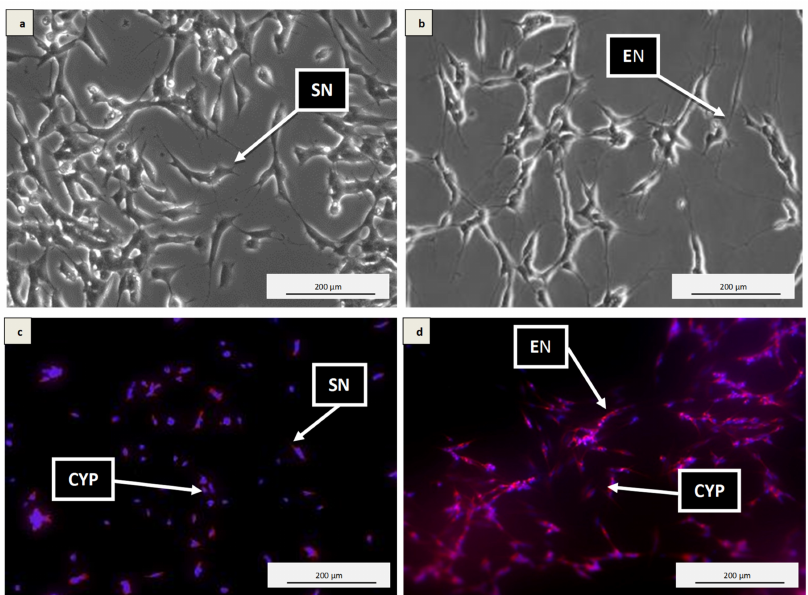
Figure 1. Micrographs of SH-SY5Y cell differentiation by 10 µ M RA. ( a ) Undifferentiated SH-SY5Y cells cultured in 10% heat-inactivated FBS complete growth media for 7 days and viewed under phase contrast, ( b ) Differentiated SH-SY5Y cells cultured in 3% heat-inactivated FBS complete growth media containing 10 µ M RA for 7 days and viewed under phase contrast, and ( c and d ) expressed tuj-1 in both neurites and cytoplasm. Extended neurites = EN, short neurites = SN, and cytoplasm = CYP. Magnification